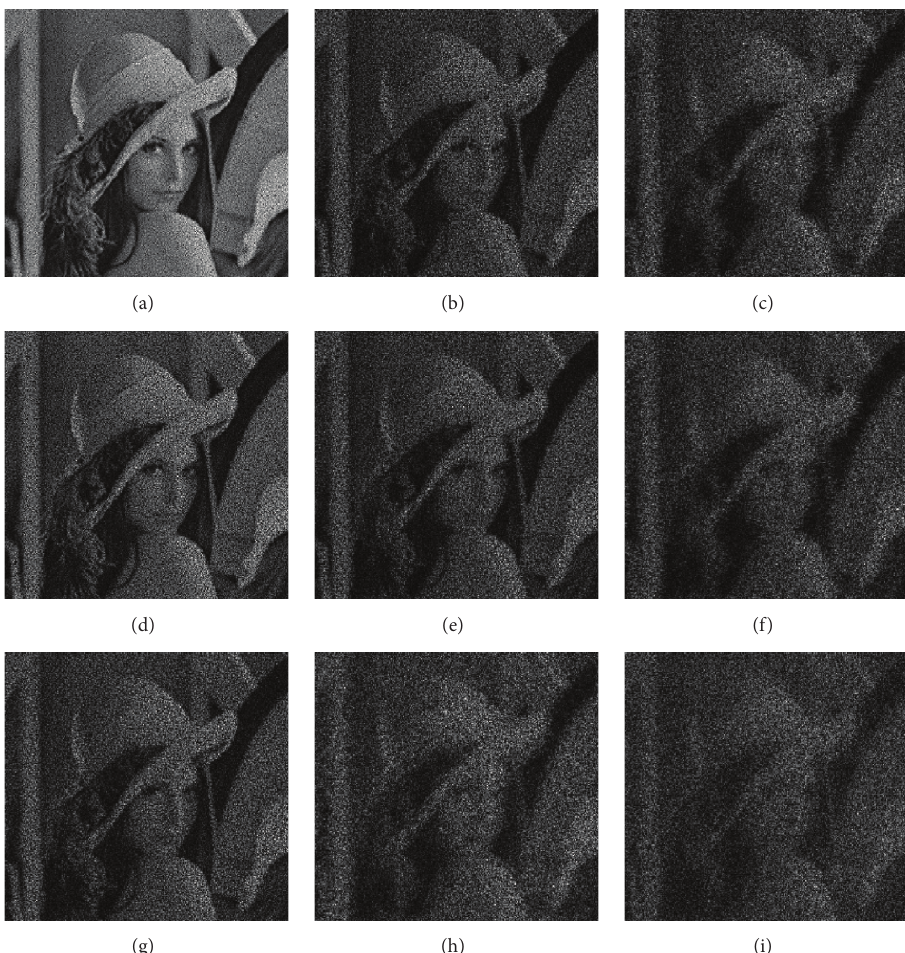
Figure 7: Results with incorrect parameters of DVTL: (a–c) decrypted images with incorrect focal lengths with deviation from correct value as 5, 10, and 50mm, respectively, (d–f) decrypted images with incorrect 𝜆 with deviation from correct value as 10, 40, and 100nm respectively, (g,h)decryptedimageswithincorrecttopologicalchargewithdeviationfromthecorrectvalueas1and9,respectively,and(i)decryptedimage with 𝑆 = 2